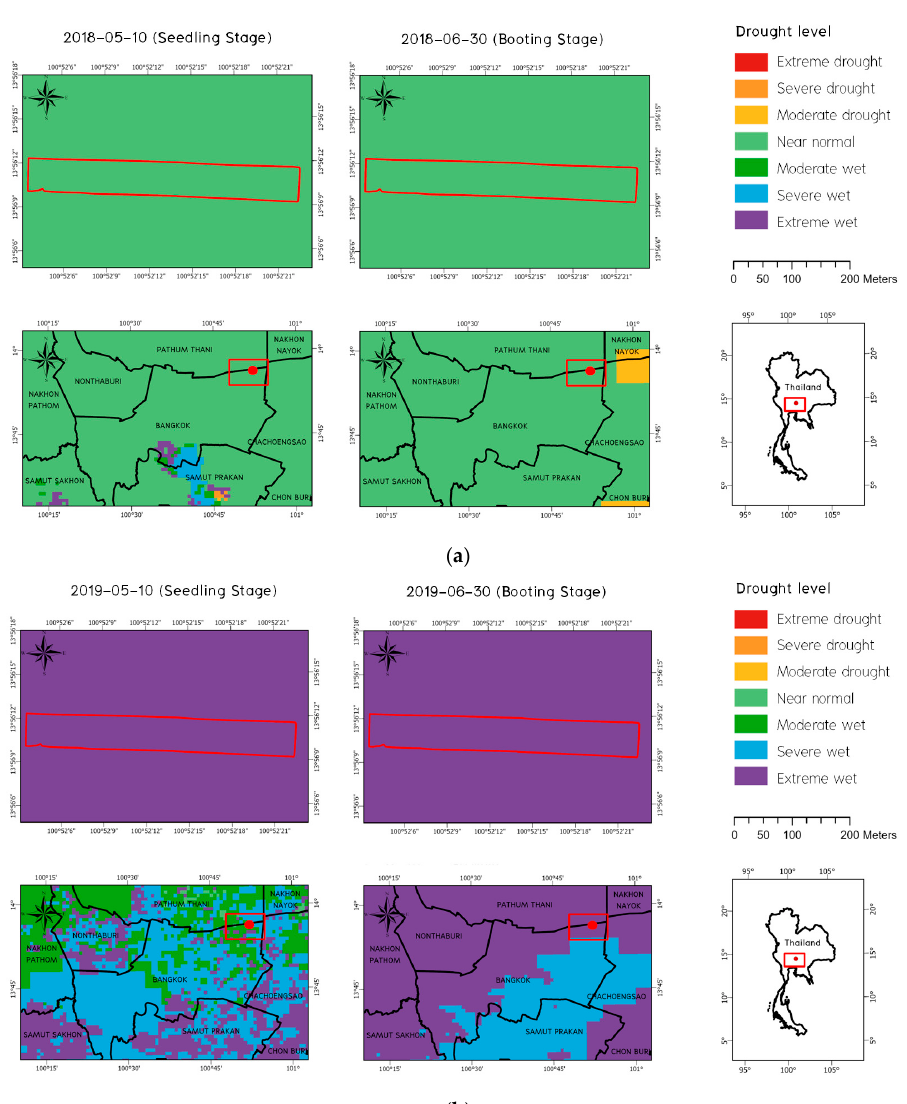
Figure 14. Time series (seedling and booting stages) of drought vulnerability index of the test site in ( a ) the 2018 crop season (near normal) and ( b ) the 2019 crop season (extreme wet). Higher wetness in the 2019 crop season may be the reason for the 14.5% higher simulated yield (4.73 ton·ha − 1 ) compared with the result from the previous year (4.13 ton·ha − 1 ). For each figure, the top figures depict the site periphery whereas the bottom figures depict its location on the map.